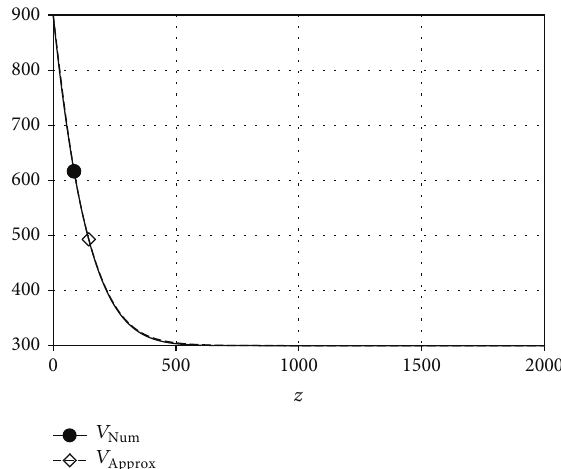
Figure 10: Approximate analytic solution 𝑉 of BVP (47), (48). solution 𝑉 Num